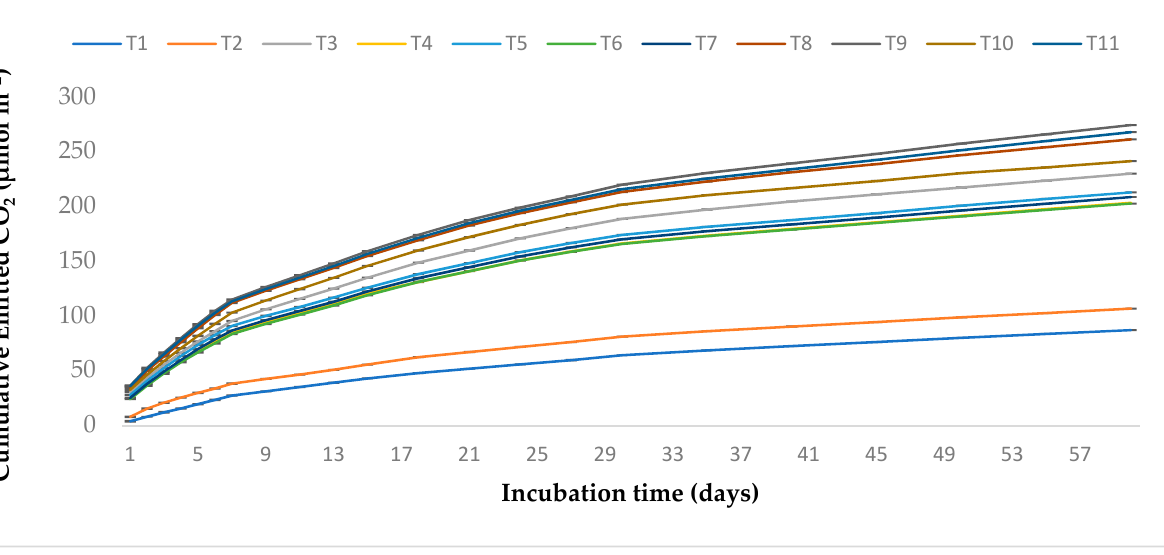
Figure 3. Effect of RHB, EFBB, and dolomitic limestone treatments on cumulative soil CO 2 emission during the 60 days of incubation, whereas bar errors show ± standard error of three replications.